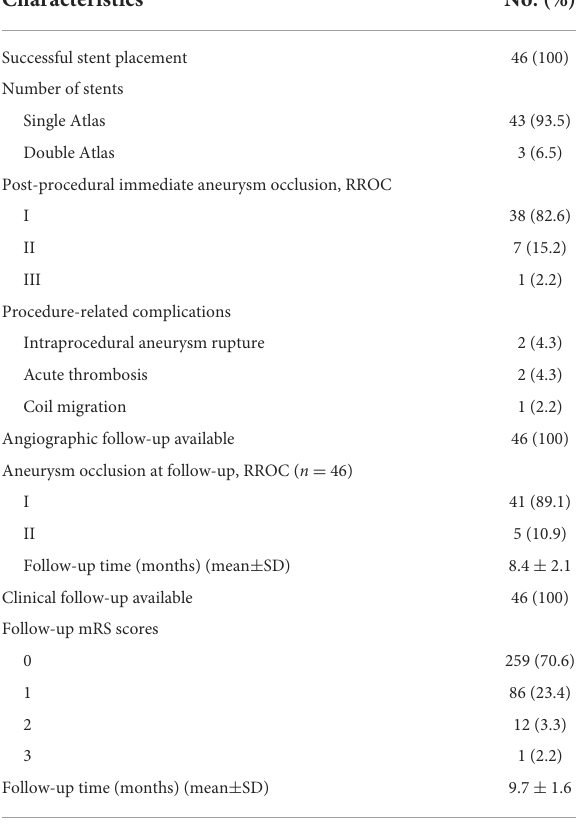
TABLE 2 Postprocedural and follow-up angiographic and clinical outcomes.